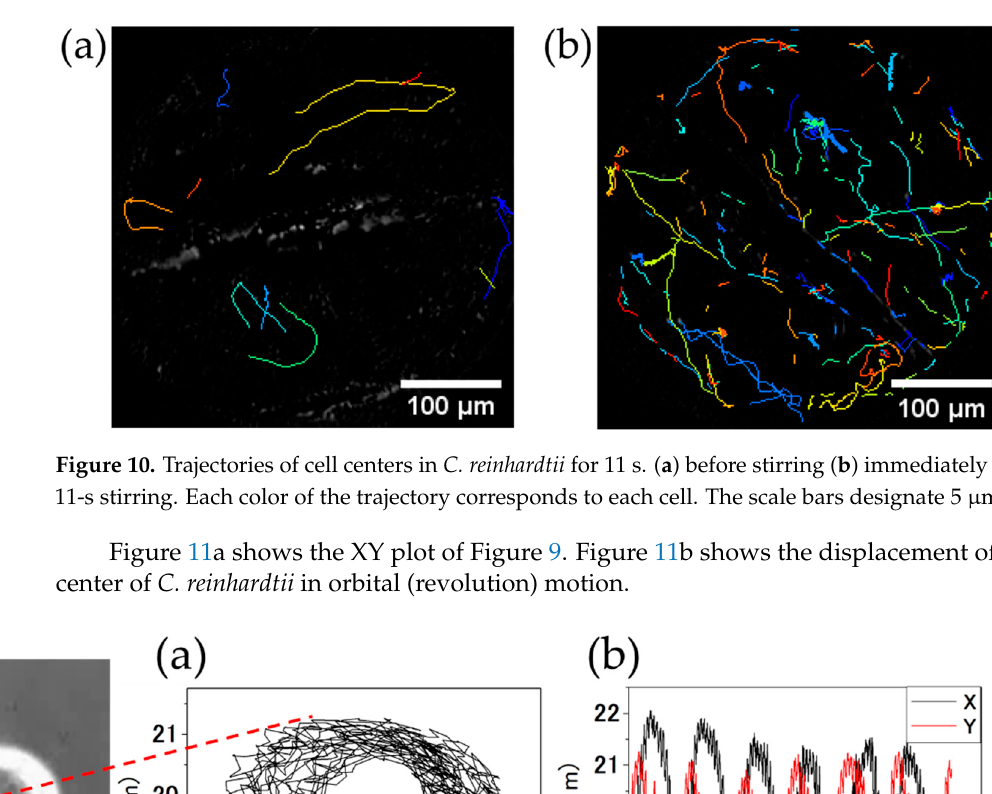
center of C. reinhardtii in orbital (revolution) motion.